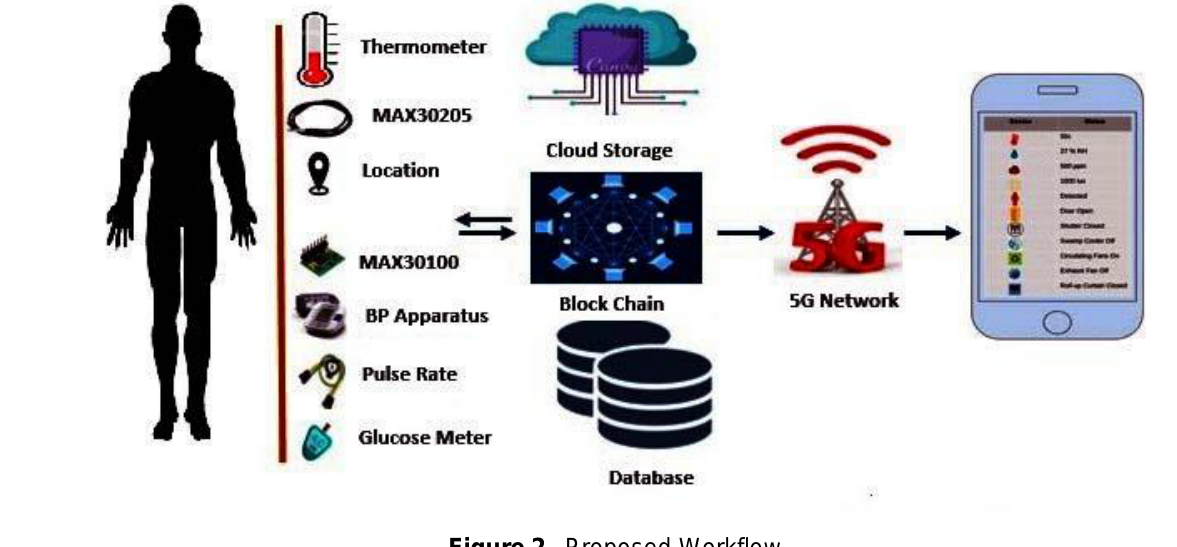
Figure 2. Proposed